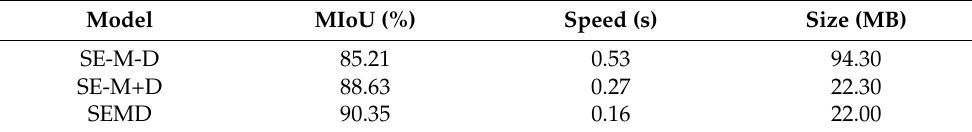
Table 8. Comparison results of different model architectures.